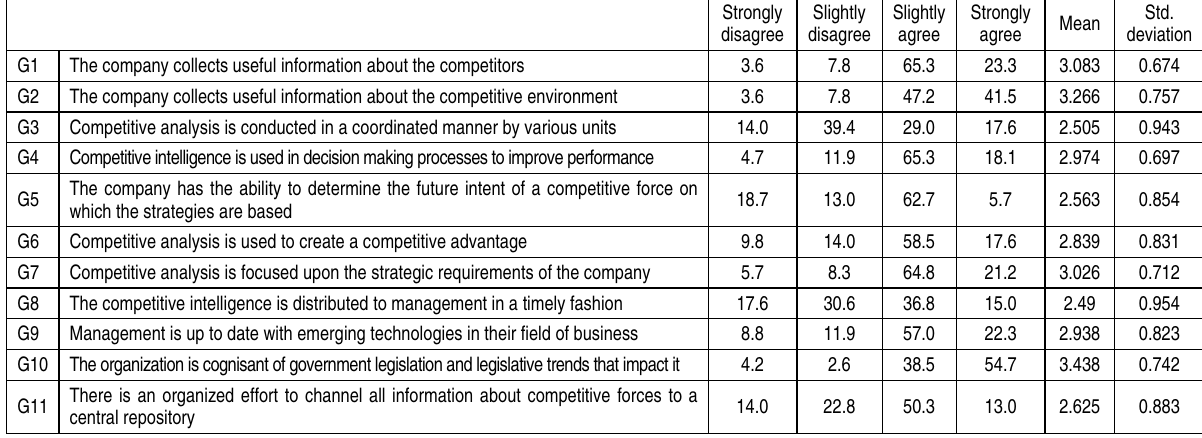
Table 2. Results of the questionnaire on competitive intelligence